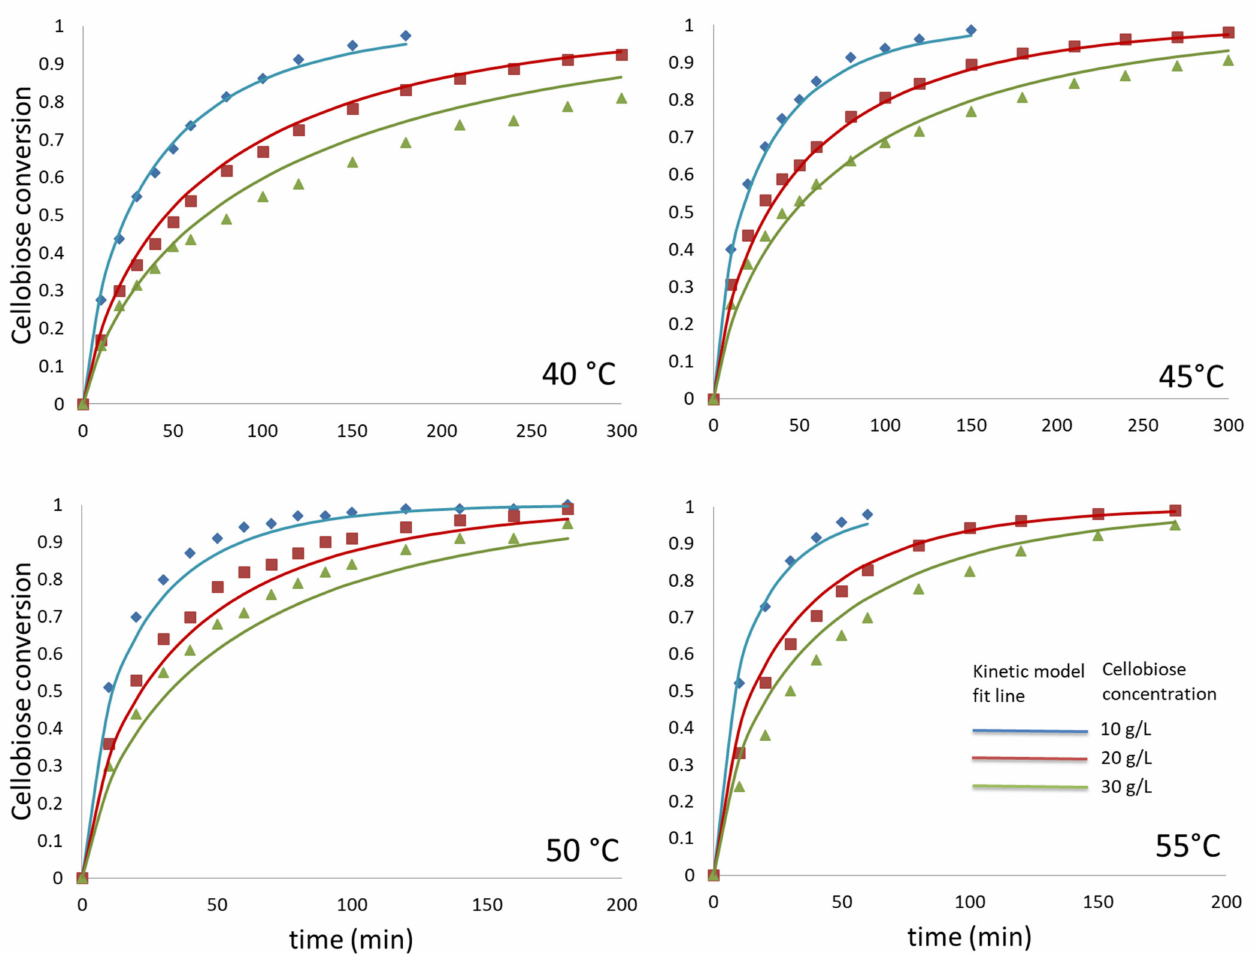
Figure 5. Fit of the proposed model (in lines) to data retrieved at all temperatures (points) tested and several cellobiose initial concentrations. Other reaction conditions: 100 mg of immobilized RN8 derivative; 2 mL sodium citrate buffer 100 mM pH